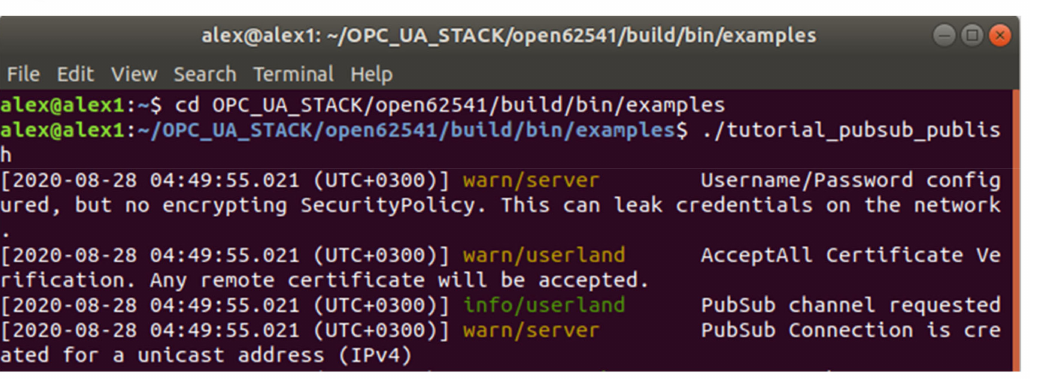
Figure 6. Terminal of the Publisher and the data that is sent to the